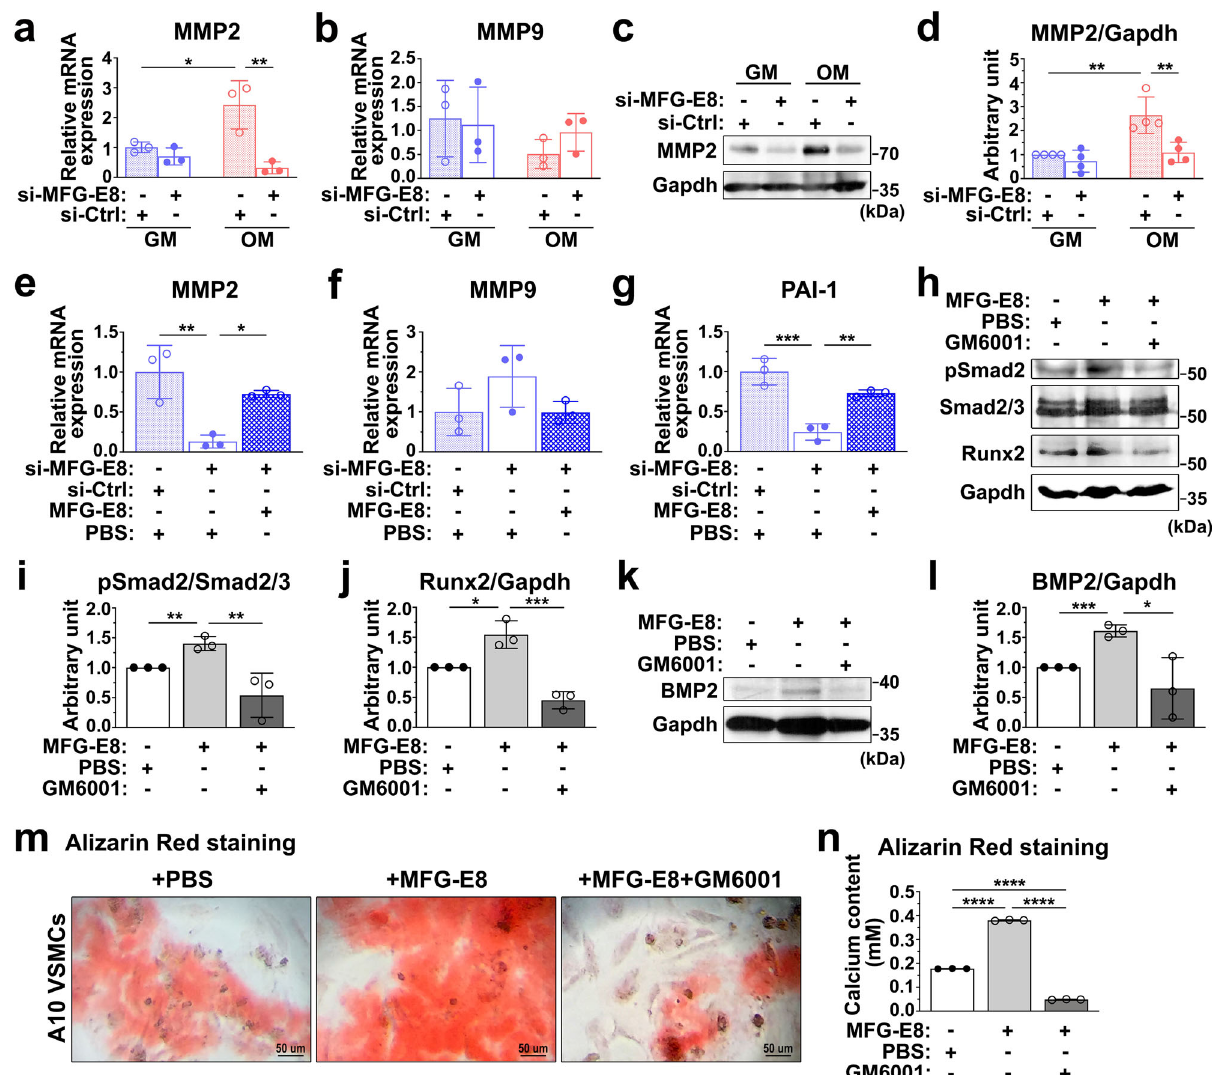
Fig. 6 Milk fat globule – epidermal growth factor 8 (MFG-E8) promotes vascular smooth muscle cell (VSMC) calci fi cation and transforming growth factor- β 1 (TGF- β 1) signaling through upregulating matrix metalloproteinase 2 (MMP2) activity. a , b A10 VSMCs treated with si-MFG-E8 or control siRNA (si-Ctrl) were cultured in growth medium (GM) and osteogenic medium (OM) for 6 h. The mRNA expression of MMP2 ( a ) and MMP9 ( b ) in VSMCs was evaluated through quantitative real-time polymerase chain reaction ( n = 3). Three independent experiments were performed. Data are presented as mean ± standard deviation (SD). Each data point was derived from each of the three repeated experiments. * P < 0.05 and ** P < 0.01, obtained using one-way analysis of variance (ANOVA) followed by Tukey ’ s multiple comparison test. c , d A10 cells transfected with si-MFG-E8 or si-Ctrl were cultured in GM and OM for 7 days. c Western blot analysis of MMP2 in VSMCs. d Quantitative analysis of MMP2 levels normalized to those of glyceraldehyde 3-phosphate dehydrogenase (GAPDH) was performed ( n = 3). Data are presented as mean ± SD. Three independent experiments were performed. Each data point was derived from each of the three repeated experiments. ** P < 0.01, obtained using one-way ANOVA followed by Tukey ’ s multiple comparison test. e – g A10 VSMCs incubated with si-Ctrl, si-MFG-E8, and si-MFG-E8 with recombinant MFG-E8 (rMFG-E8) (100 ng/mL) were cultured in OM for 7 days. The transcript expression levels of MMP2 ( e ), MMP9 ( f ), and PAI-1 ( g ) were evaluated through quantitative real-time polymerase chain reaction ( n = 3). Data are presented as mean ± SD. Three independent experiments were performed. Each data point was derived